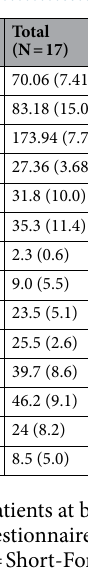
Figure 1. Flow chart of the intervention.